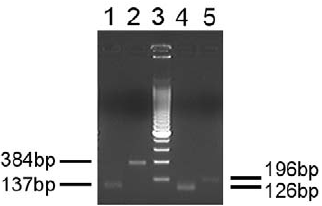
Figure 1. PCR products of the XMRV VP62 clone. Primers are generic to MLV (lanes 1 and 2) or specific to XMRV (lanes 4 and 5). The sizes of the respective fragments are shown. Lane 3–200 bp molecular size ladder. Figure 2. Nested PCR from the DNA of 8 CFS patients. Products of generic MLV primers (including XMRV) are shown. Lanes 1–8, CFS patient DNA (2 nd round); lanes 9 and 10, XMRV 2 nd round and 1 st round positive controls; lanes 11 and 12, DNA of uninfected cell line